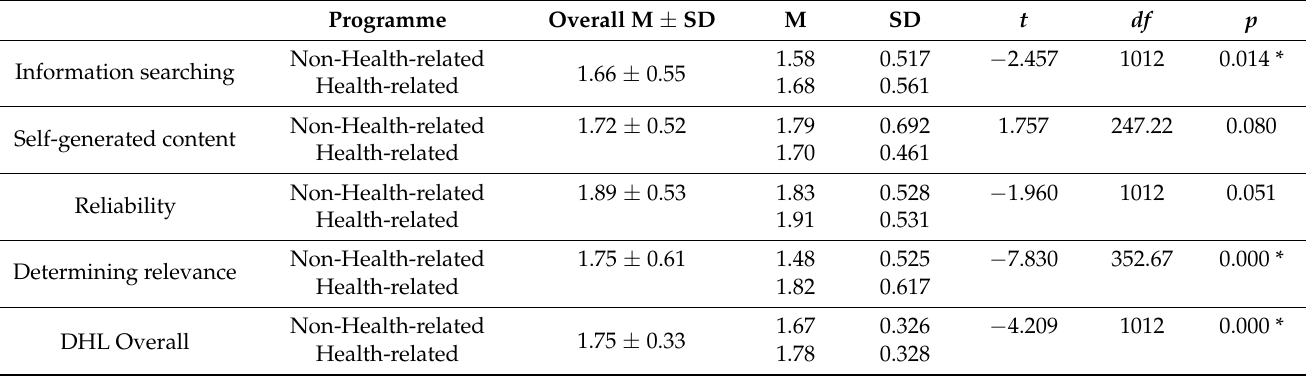
Table 5. COVID-19 Digital health literacy of university students based on programme